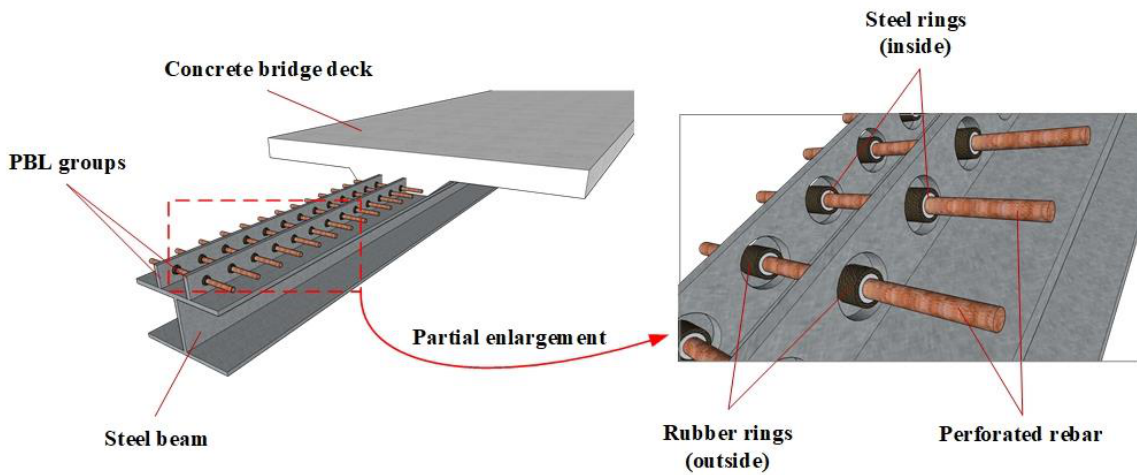
Figure 1. Application of the PBL connector with steel – rubber tenon.